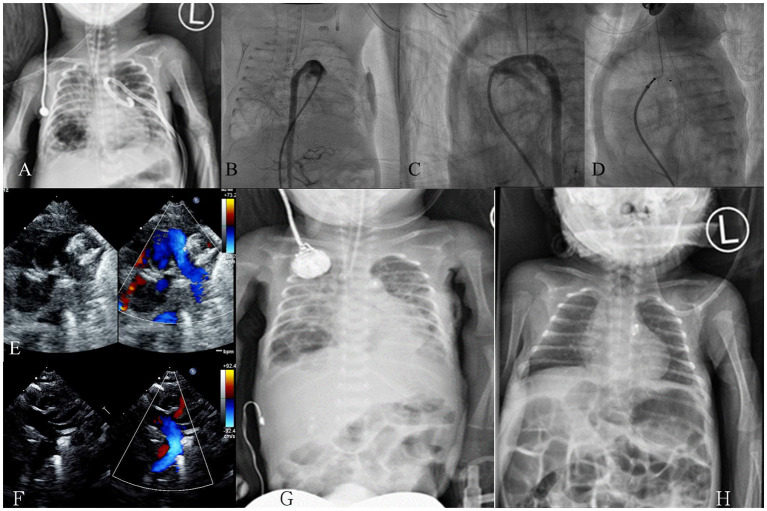
Case demonstration in a premature baby with a gestational age of 26 ± 3 weeks and a birth body weight of 766 g. (A) Chest X-ray on day 34 revealed poor lung condition with a left side pneumothorax post pigtail catheter; (B) On day 36 (body weight, 836 g), an anteroposterior view angiogram revealed a large tubular PDA; (C) Lateral view angiogram revealed a tubular type-C PDA, size: 2.9 mm, length: 6.4 mm; (D) An ADO-II-AS (4 × 4 mm) device was deployed on day 36; (E) Echocardiogram revealed device in position without pulmonary artery obstruction; (F) Echocardiogram revealed no evidence of coarctation of the aorta; (G) Follow-up chest X-ray on day 38 (2 days after the procedure) revealed rapid improvement; (H) Follow-up chest X-ray on day 70 (34 days after the procedure) revealed favorable condition. ADO-II-AS, Amplatzer Duct Occluder II with additional size; PDA, patent ductus arteriosus.